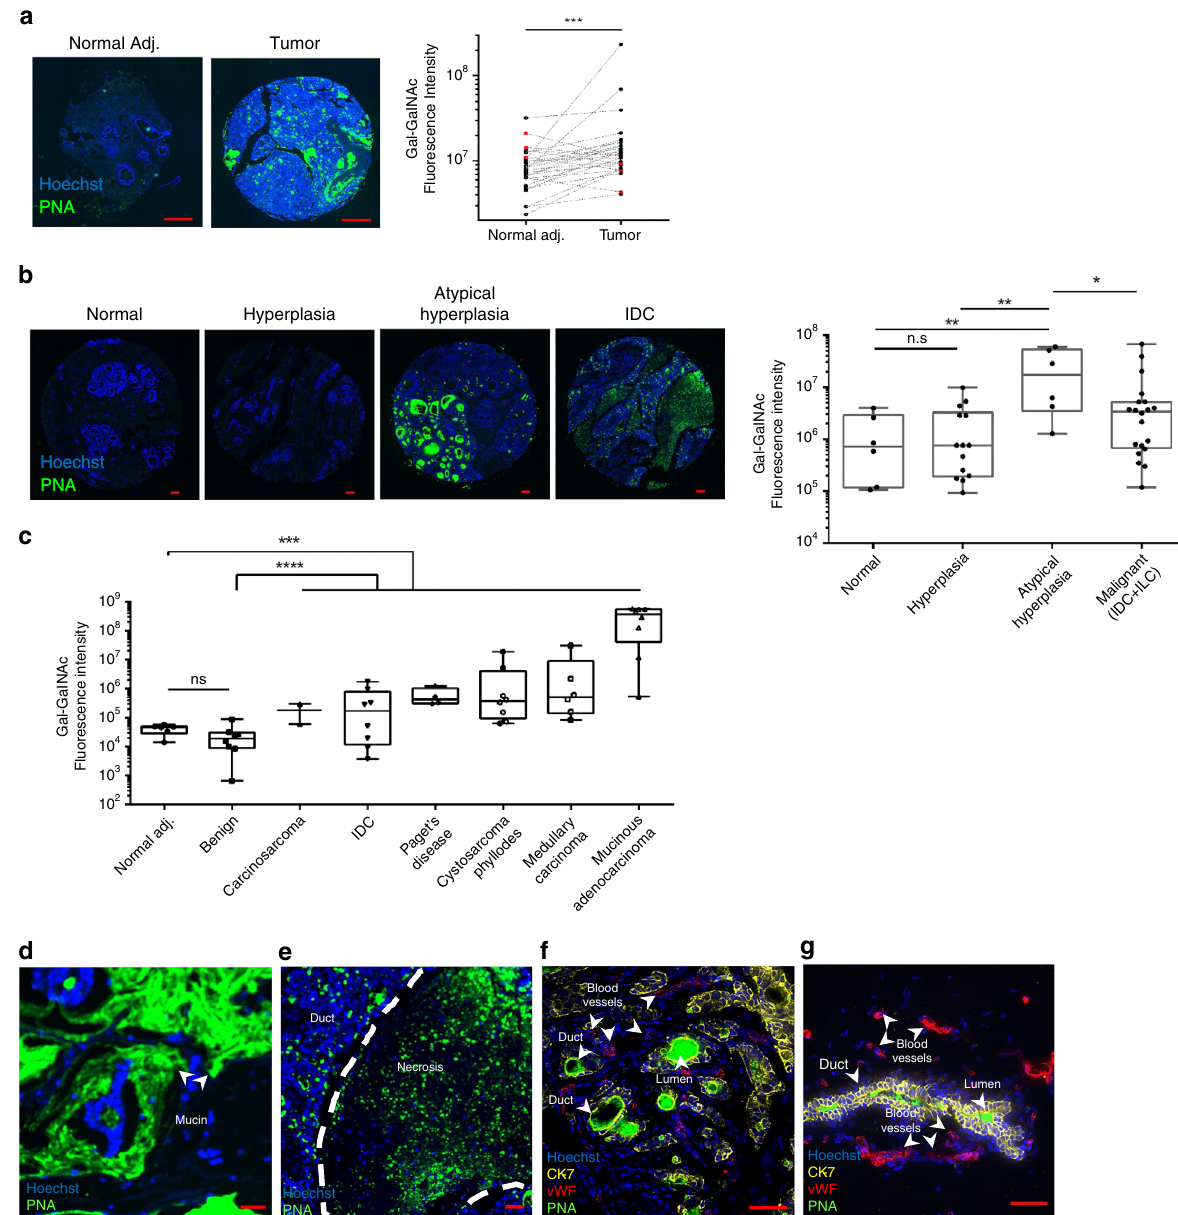
Fig. 1 Gal-GalNAc is overdisplayed in breast cancer. a Representative images of human breast cancer and matched adjacent non-tumor (normal adj.) tissue using tissue microarray (HBre-Duc060CS-01) stained with FITC-labeled Gal-GalNAc-speci fi c PNA lectin (green) and Hoechst dye (blue). Right panel: quantitative analysis of PNA binding (sum of fl uorescence intensity) to each matching tumor and normal adjacent tissue cores. Each paired symbols represents one patient. Red symbols mark the fi ve paired samples (out of 30) in which Gal-GalNAc level in the normal tissue was higher than that in the adjacent-tumor one. *** p = 0.0003, one-tailed, Wilcoxon matched-paired signed rank test, n = 30. b Representative images of human breast cancer hyperplasia, atypical hyperplasia, and normal tissue using tissue microarray (BR1003a) stained with FITC-labeled Gal-GalNAc-speci fi c PNA lectin (green) and Hoechst dye (blue) (left panel). Right panel: quantitative analysis of PNA binding (sum of fl uorescence intensity) to each tissue core. Each symbol represents one patient. ** p = 0.0035 (normal – atypical hyperplasia), ** p = 0.002 (hyperplasia – atypical hyperplasia), * p = 0.0415, n.s.: not signi fi cant, two- tailed Kruskal – Wallis test, normal n = 6, hyperplasia n = 14, atypical hyperplasia n = 6, malignant n = 20 (IDC + ILC, IDC: invasive ductal carcinoma, ILC: invasive lobular carcinoma). c Quantitative analysis of PNA binding (sum of fl uorescence intensity) to types of human breast cancer, benign and normal adjacent (none matched) tissue using tissue microarray (BR1006) stained with FITC-labeled PNA. Each symbol represents one patient. *** p = 0.0004, **** p < 0.0001 between all the breast cancers and normal adj. and benign correspondingly, Holm-corrected Mann – Whitney test. n = 6 (normal adj.), n = 7 (benign), n = 36 (malignant). d – g Human breast cancer stained with FITC-labeled PNA (green), Cy5-anti-Cytokeratin-7 for glandular epithelia (yellow), TRITC-von willebrand factor for endothelial cells (red), and Hoechst dye (blue). High Gal-GalNAc levels can be detected in mucin regions in mucinous breast carcinoma ( d ), and in necrotic regions ( e ), and in duct and in duct lumen ( e , f , g ) of ductal breast cancer as indicated. Scale bar, 100 µ m in ( a , b ), 50 µ m in ( d – g ). Results presented in ( d ) and in ( e – g ) represent 2 and 3 reproducible independent experiments, respectively. Source data are provided as a Source data fi